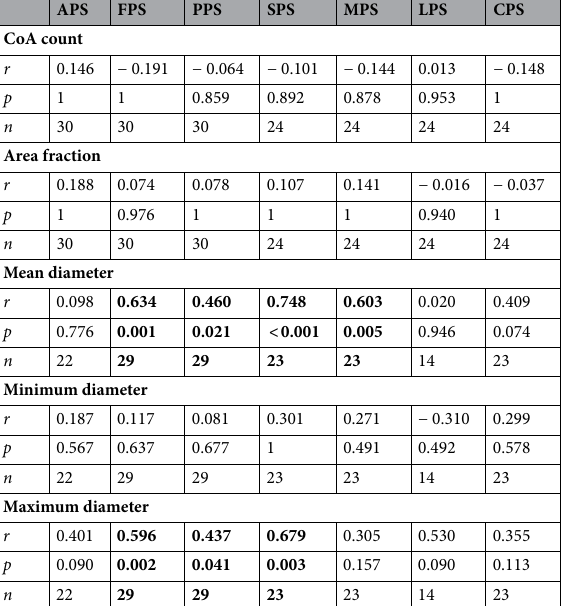
Table 3. Spearman’s Rho correlation of patient age with tested CoA parameters. Significant differences are indicated in bold. The listed p values are after adjustment for Type 1 error with FDR. APS alveus pial